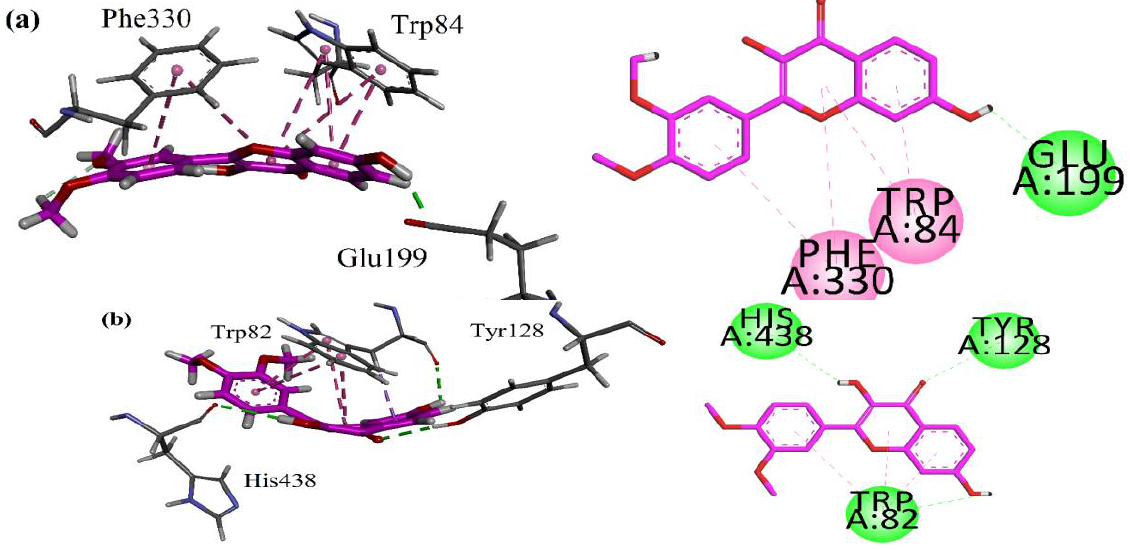
Figure 4. 3-D/2D interaction plots of compound in the binding sites of ( a ) AChE (PDB 1EVE) and ( b ) BChE (PDB ( b ) BChE (PDB 4BDS).